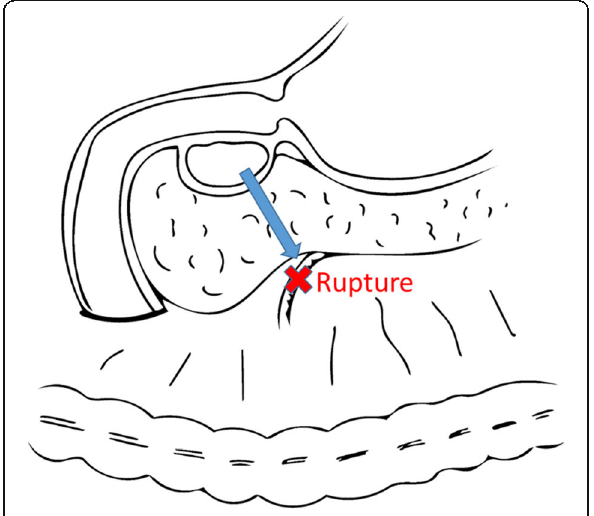
Fig. 4 Schema of case 1. Pancreatic juice contained in the duodenal duplication leaked out and injured the arterial